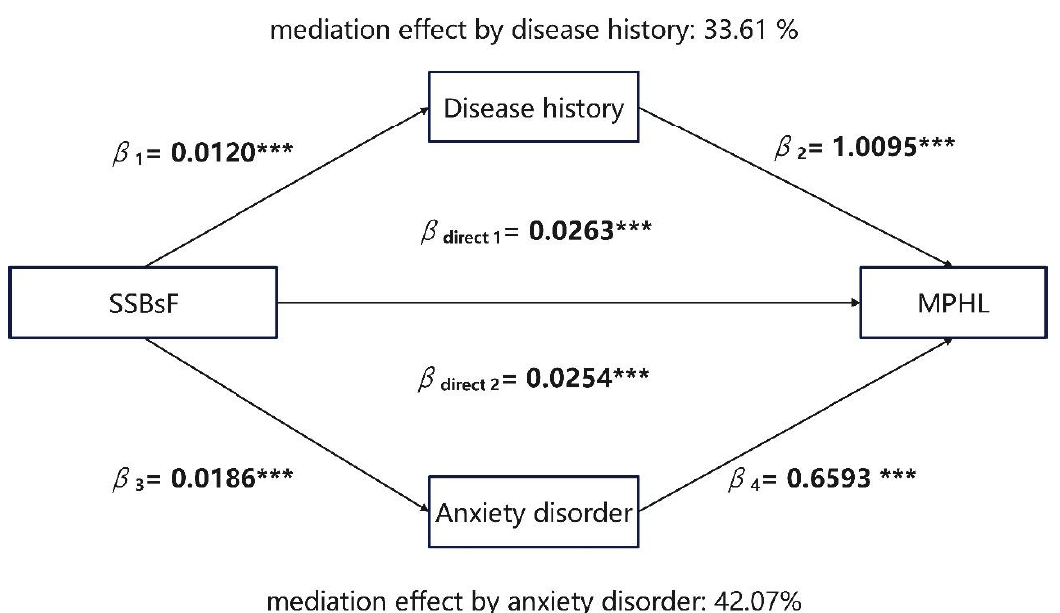
Figure 4. Mediation effect diagram for disease history and anxiety disorder in association between Sugar-Sweetened Beverages (SSBs) intake frequency and male pattern hair loss (MPHL). Anxiety disorder status was divided into four levels according to GAD-7. Score range included: 0–4 minimal anxiety, 5–9 mild anxiety, 10–14 moderate anxiety, 15–21 severe anxiety. Disease history was divided into three groups: without disease, one chronic disease and more than one disease. SSBsF means SSB intake frequency, which was included as a continuous variable in the mediation analysis. MPHL was divided into two groups according to BASP scale: normal group and MPHL group. * p < 0.05, ** p < 0.01, *** p < 0.001.